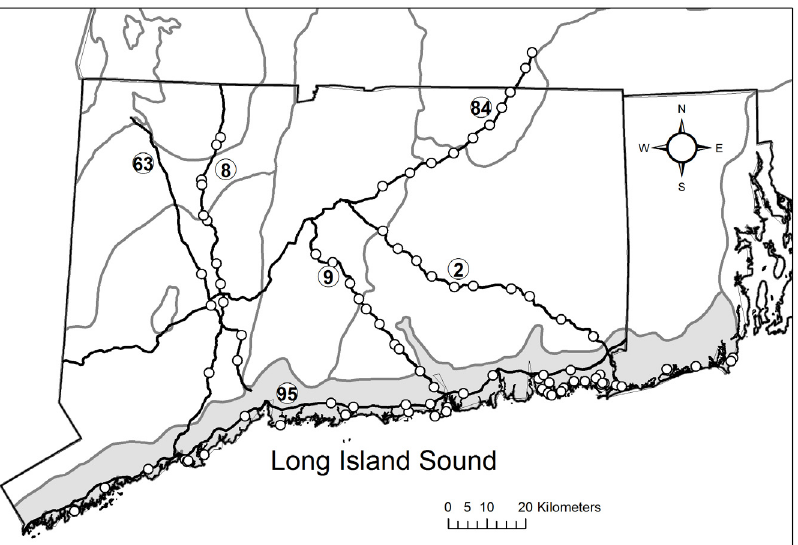
Fig 1. Map of the study site. Switchgrass collection sites (open circles). Black lines represent borders of Connecticut and Rhode Island and six roads identified as Routes 63, 8, 9, 95, 84,and 2. Grey lines represent the borders of Level IV sub-ecoregions. The shaded area represents Level IV sub-ecoregion 59g Long Island Sound Coastal Lowland.